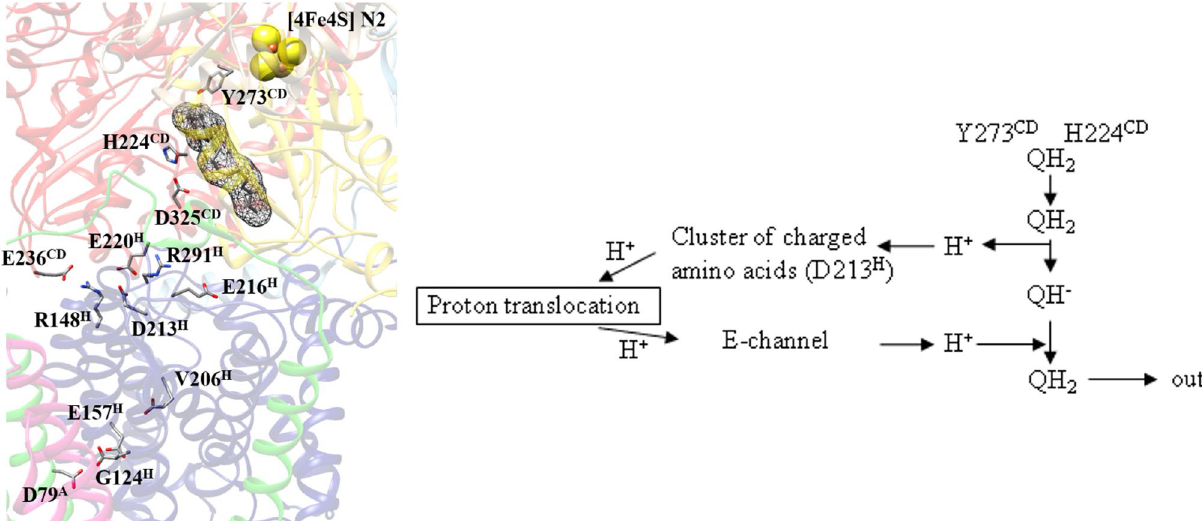
Figure 7. Proposed mechanism to activate proton pumping in respiratory complex I. The structure of the quinone binding site with the cluster of charged amino acids and residues of the E-channel are shown ( T. thermophilus complex I, PDB: 6I0D 82 ) . For clarity, residues are labeled according to the E. coli numbering. Q is bound close to iron-sulfur cluster N2 where it is reduced by N2 and protonated by Y273 CD and H224 CD . According to the proposed model, the product QH 2 moves to a second binding position in close vicinity to an area of charged amino acids, where it is deprotonated resulting in the formation of the QH - anion, while the proton is transferred into the area of charged amino acids comprising D213 H . This proton transfer activates proton translocation as described 44 resulting in a surplus proton on an acidic amino acid of the E-channel after proton translocation. This proton is transferred to the QH − anion leading to the formation of QH 2 that is released from the also reported that single point mutations in NuoL (e.g. R431 L ) 55 and in NuoN (e.g. K217) 56 fully disturbed the assembly of complex I. The inversion of 7 bps on mitochondrial DNA (m.3902-3908inv7; MT-ND1) leads to a triple mutation on